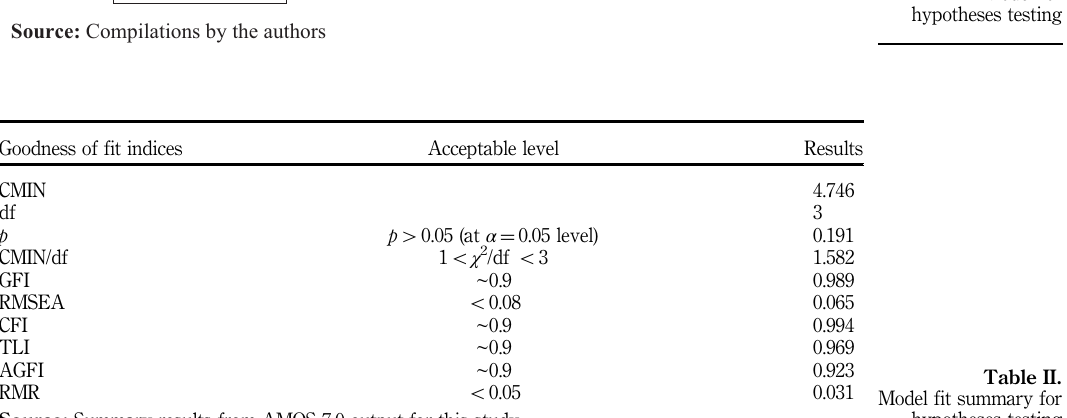
Figure 1. Model for